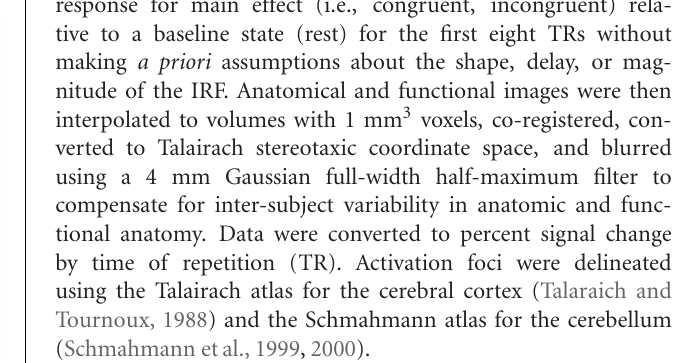
the central arrow was pointing (left versus right) while ignoring the two flanking arrows on each side. On half the trials, the flank- ing arrows pointed in the same direction as the central arrow cue (e.g., <<<<< ; congruent condition), and on the other half of the trials the flanking arrows pointed in the opposite direction (e.g.,